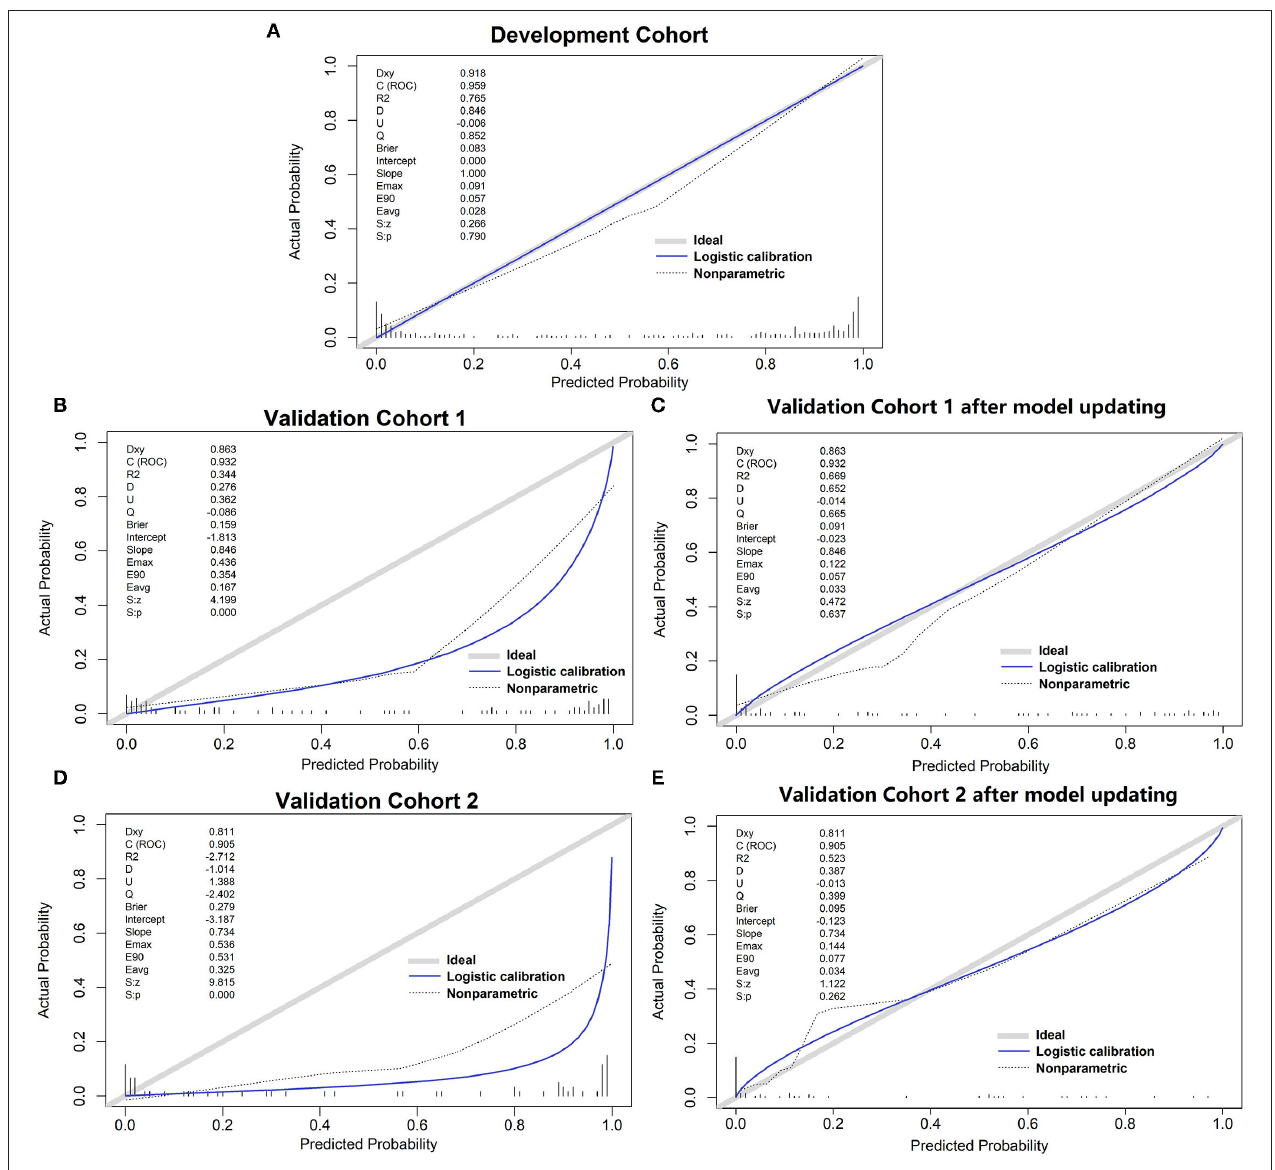
FIGURE 3 | The calibration curve of different models. (A) development set; (B) validation cohort 1; (C) validation cohort 1 after model updating; (D) validation cohort 2; (E) validation cohort 2 after model updating.